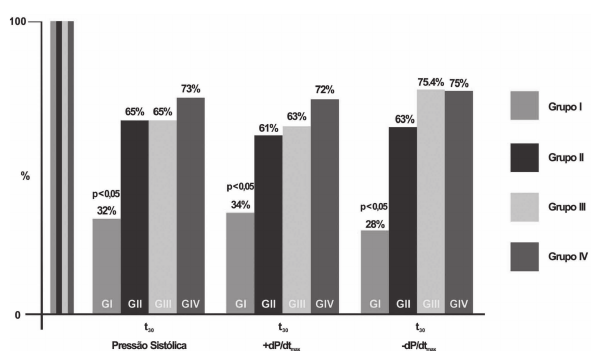
Fig. 3 – Mean percentage changes of results in the studied